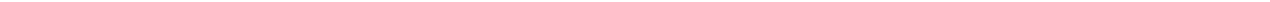
Fig. 5 Sub-threshold inputs are maintained by dLTP. a Cartoon of the simulation: two groups of synapses are placed at proximal compartments. Group 1 codes for a circle, group 2 for the colour blue. While the groups are often activated separately, the neuron should only generate an output in the rare event of a blue circle (i.e., both groups active simultaneously). b Top panel: somatic trace during the simulation. Middle panels: detail of the somatic trace during the initial and fi nal part of the simulation. While a blue circle leads to action potentials initially, it eventually becomes sub-threshold. Bottom panels: dendritic traces at the proximal location of cluster 2, corresponding to the somatic traces in the middle panel. c Evolution of synaptic weights of both groups during the simulation. The individual activations of the groups lead to depression, the simultaneous activations result in potentiation initially, but are insuf fi cient to keep the synapses at the maximum weight. Finally, the simultaneous activations become sub-threshold and the weights depress towards the lower bound. d – f Analogous to a – c , but connecting the groups at distal locations on basal dendrites. The individual activations of the groups now lead to NMDA spikes (see panel e , bottom, for the second group), keeping the weights at the upper bound ( f ) and allowing the neuron to maintain its red circle representation ( e , top and